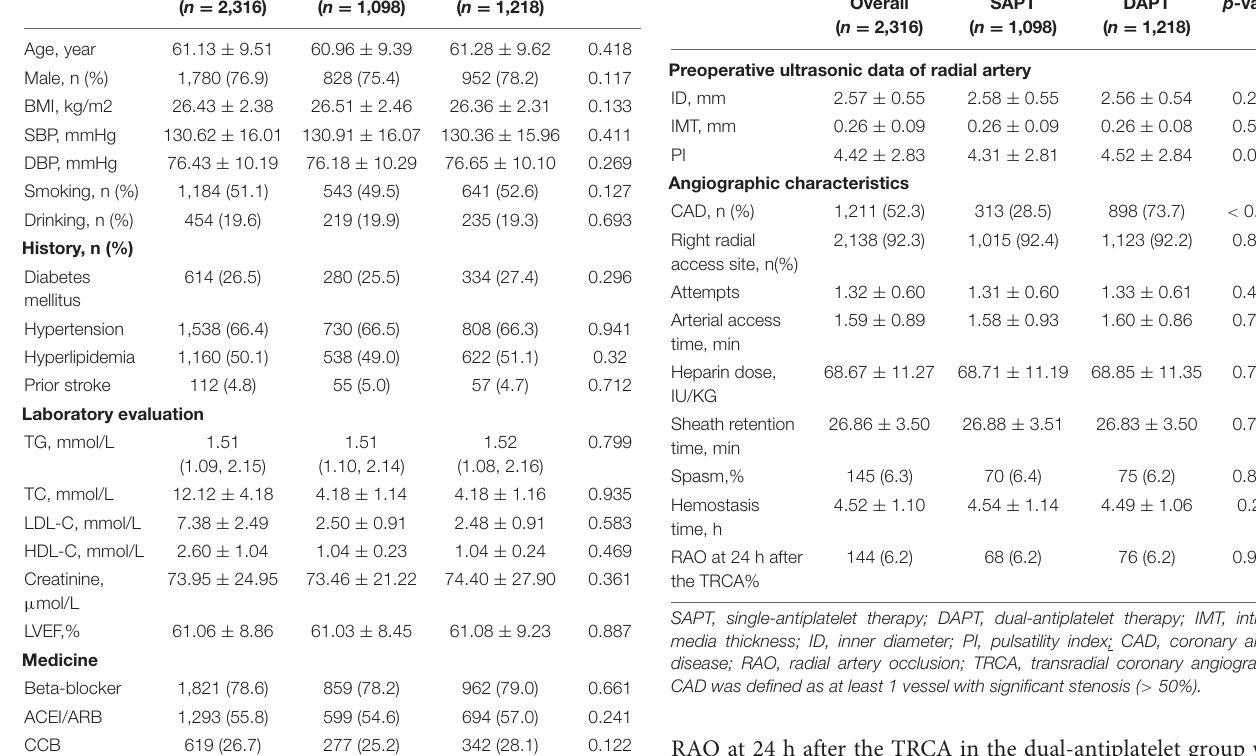
TABLE 1 | Baseline demographic and clinical characteristics.